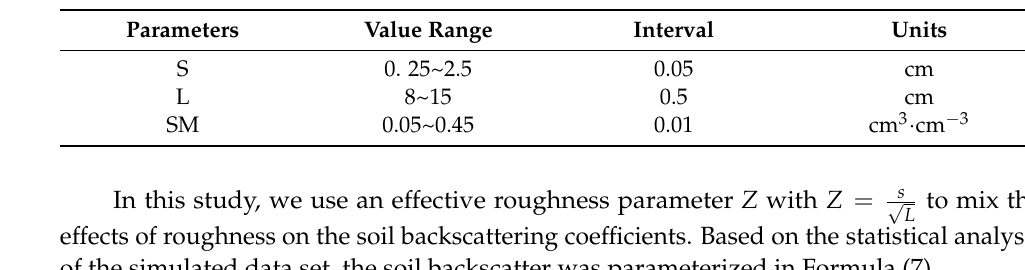
Table 4. The main input parameters of AIEM